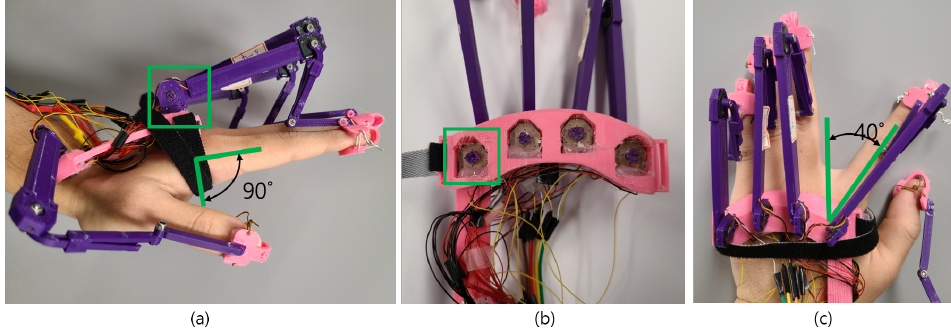
Figure 3. Proposed haptic glove with rotary position sensor placed in MCP joints. ( a ) rotary position sensor placed in the upper structure of the glove connected with exoskeleton hand to measure flexion/extension. ( b ) another rotary position sensor placed in the lower structure of the proposed glove connected to the exoskeleton hand with knob to measure adduction/abduction. ( c ) demonstration of performing adduction and abduction ranging from 0 ◦ to 40 ◦